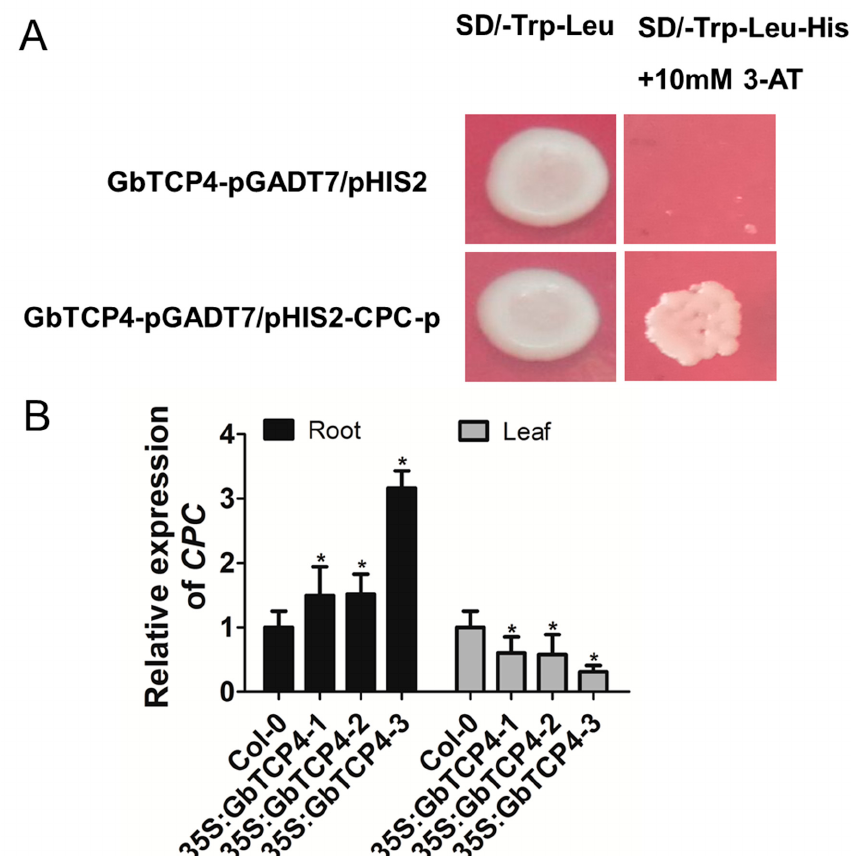
Figure 7. CAPRICE ( CPC ) is a target gene of GbTCP4 . ( A ) Analyses of the binding of GbTCP4 to the TCP-binding cis -element in the promoter of CPC . ( B ) Detection of the transcription levels of CPC gene in the roots and leaves of Col-0 and 35S:GbTCP4 seedlings by qPCR. The transcriptional levels were calibrated by the control (Col-0). AtUBQ3 expression was used as a control. Values represent the means of three biological replicates, and error bars represent standard deviations. Asterisks indicate significant differences (* p < 0.05) relative to Col-0.